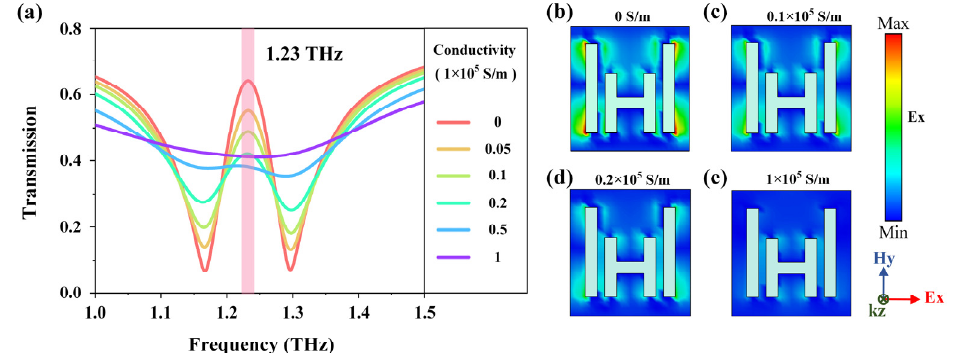
Figure 3. Simulated THz modulations of the hybrid EIT metasurface covered by the 10 ‐ nm thick MoTe 2 film. ( a ) THz transmission spectra with various conductivity of the MoTe 2 film from 0 S/m to 1 × 10 5 S/m. ( b – e ) Near E ‐ field distributions above the metasurfaces at frequency of 1.23 THz within a unit cell.